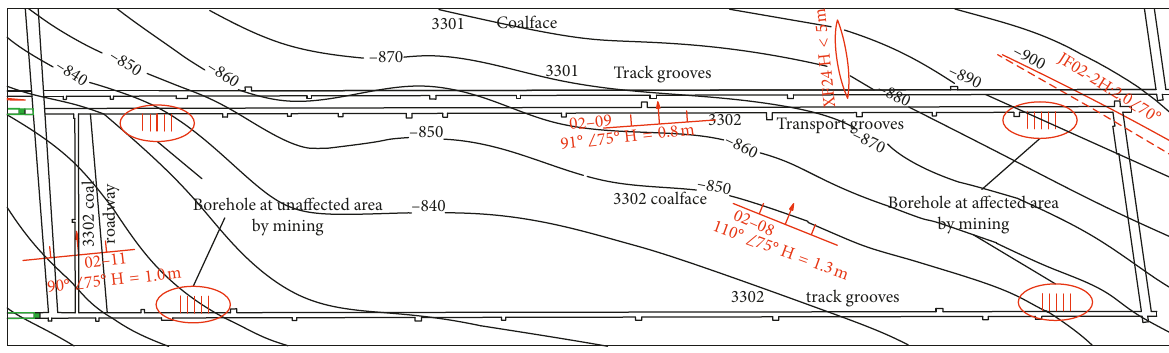
Figure 3: Borehole arrangement position of No. 3302 coalface.